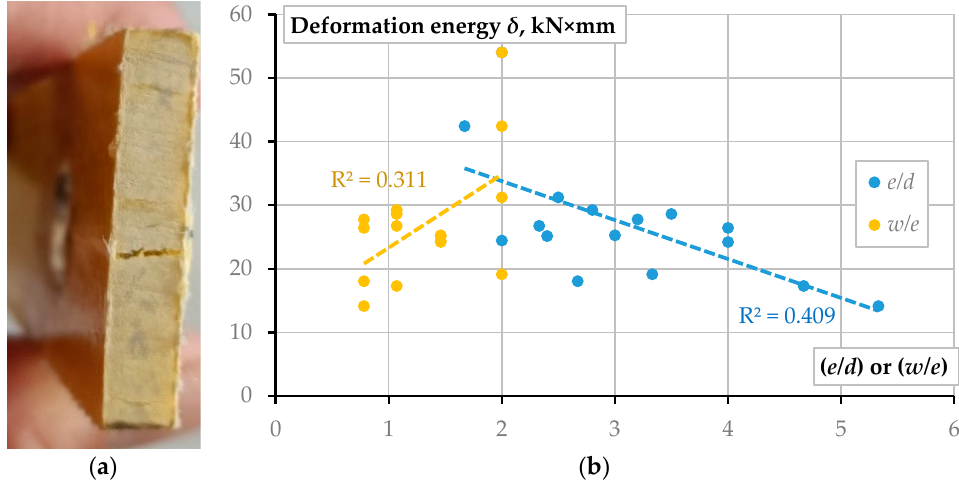
Figure 7. Summary of the test results: ( a ) A typical cleavage failure of the unidirectional pultruded core; ( b ) The deformation energy (Equation (1)) variation tendency.